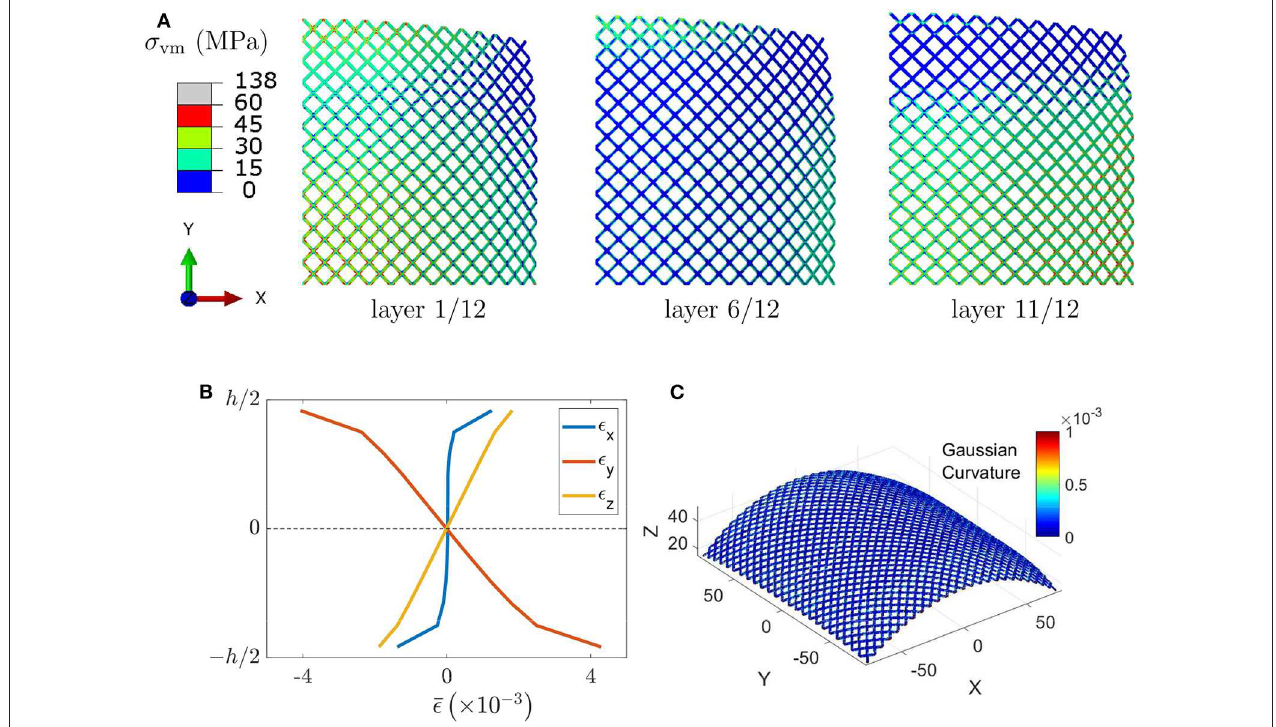
FIGURE 8 | (A) The von Mises stress is shown for a quarter of the planform at different locations through the thickness. (B) The average strains through the thickness of the shell are symmetric about the midplane, indicating the inextentional nature of the deformation. (C) The Gaussian curvature across the midplane is displayed to demonstrate it is close to zero